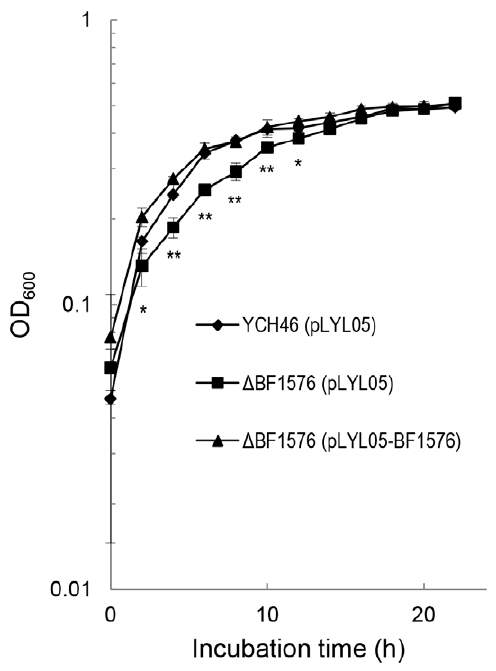
Figure 3. Repletion of BF1576 by plasmid complementation. B. fragilis wild type strains harboring pLYL05-Exp and the D BF1576 strain harboring pLYL05-Exp or pLYL1576 were grown anaerobically in a limiting amount of Pi (0.0066 mM of KH 2 PO 4 ) in DMM supplemented with 50 m g/ml of cefoxitin. Growth was measured at OD 600 . Data were calculated from triplicate cultures and expressed as means 6 standard deviations. **Significantly different from the D BF1576 strain harboring pLYL05-Exp ( p , 0.01), *Significantly different from the D BF1576 strain harboring pLYL05-Exp ( p , 0.05).